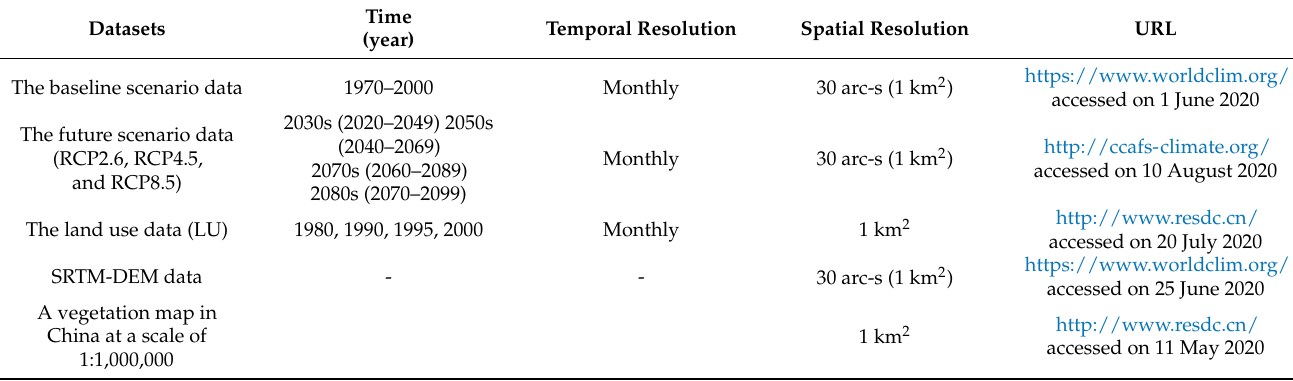
Table 1. Datasets used in this